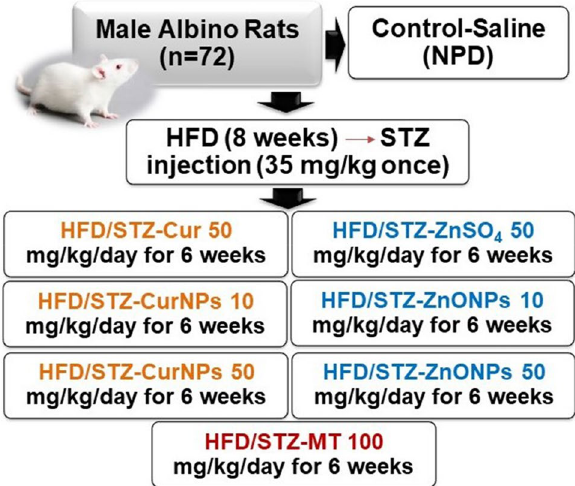
Figure 1. Experimental design and group